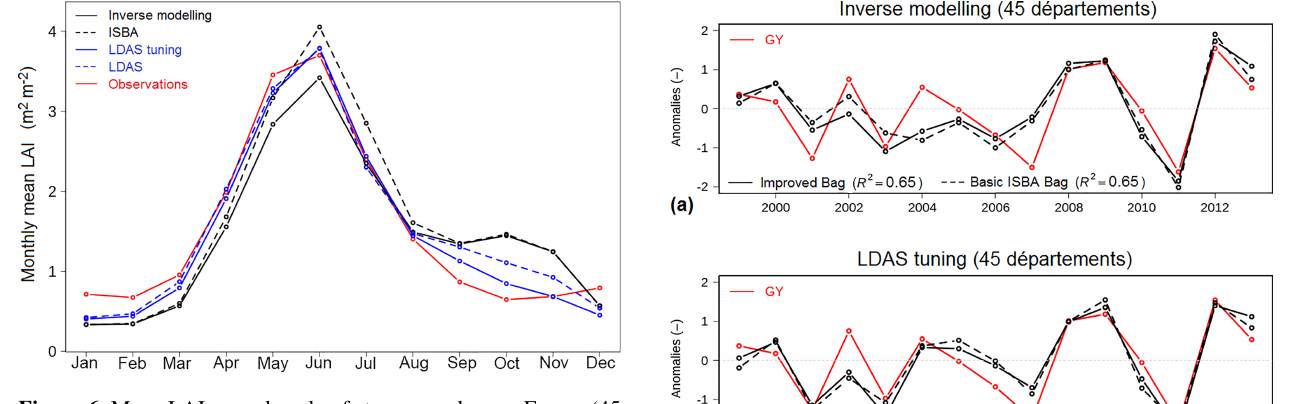
Figure 6. Mean LAI annual cycle of straw cereals over France (45 départements) during the 1999–2013 period: satellite-derived obser- vations (red line); basic ISBA simulation (dark dashed line); origi- nal LDAS simulation (blue dashed line); inverse modelling simula- tion (solid dark line); LDAS tuning simulation (solid blue line). 24 départements. With only 16 validated départements, in- simulations.